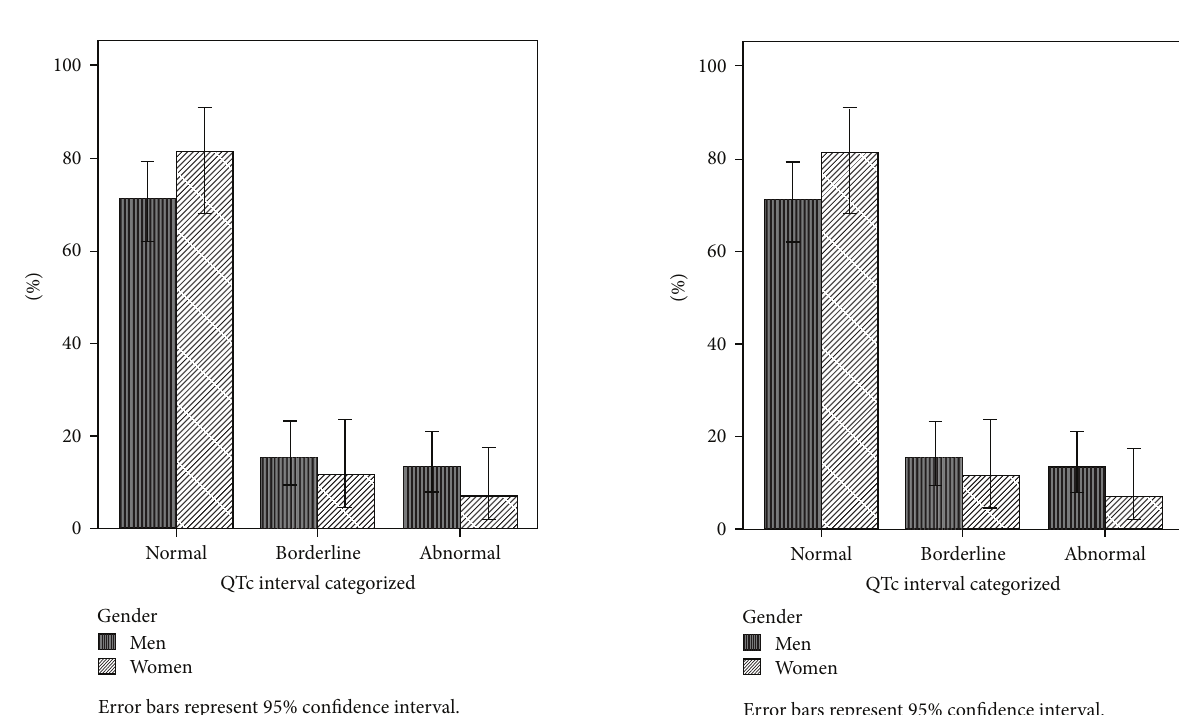
Figure 1: Distribution of QTc intervals at baseline. Figure 2: Distribution of QTc intervals at discharge/6